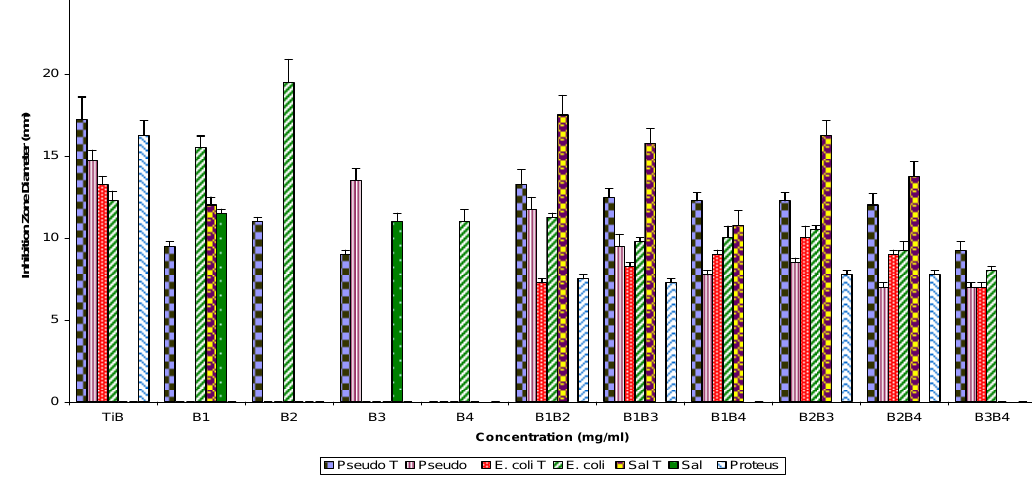
Figure 3. Antibacterial susceptibility pattern of Gram negative bacterial test strains to fraction TiB, its refraction products singly and in